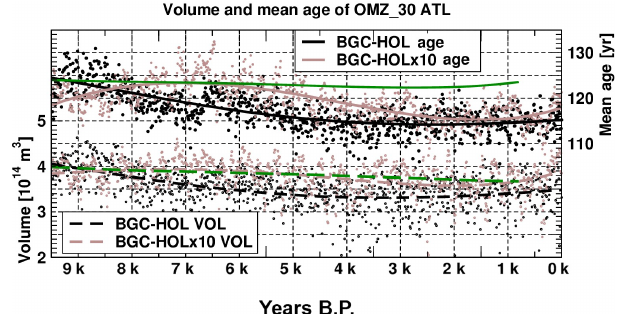
Figure 14. As Fig. 12 but for the Atlantic in the area of 5 ◦ W– 15 ◦ E, 30 ◦ S–5 ◦ N, 0–1000m depth. OMZ volume for a threshold of 30µmolL − 1 in 10 14 m 3 and water mass age in years.